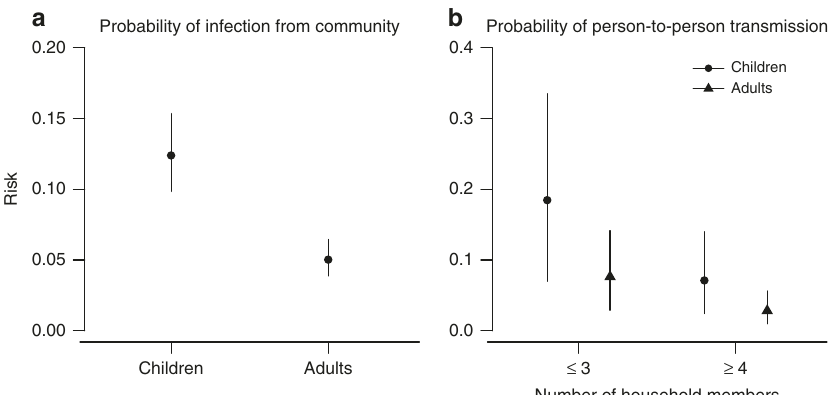
Fig. 4 Estimated probability of infection from the community and person-to-person transmission in households for individuals with a lower level of titer. Point and line indicates the point estimate and the 95% credible interval of the estimate, respectively. 95% credible intervals are constructed by using MCMC to fi t the data with digraph model. a Estimated probability of infection from the community over the study period. b Estimated probability of person-to-person transmission in households, as a function of household size